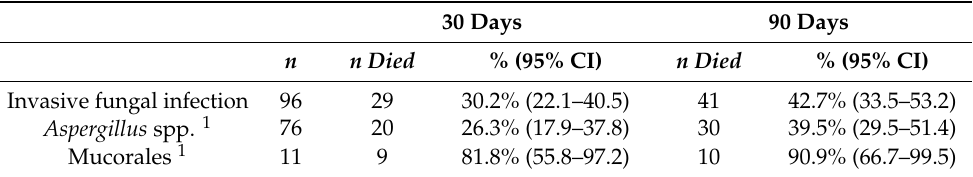
Table 6. Kaplan–Meier estimates of all-cause mortality for patients with invasive filamentous fungal infections at different time